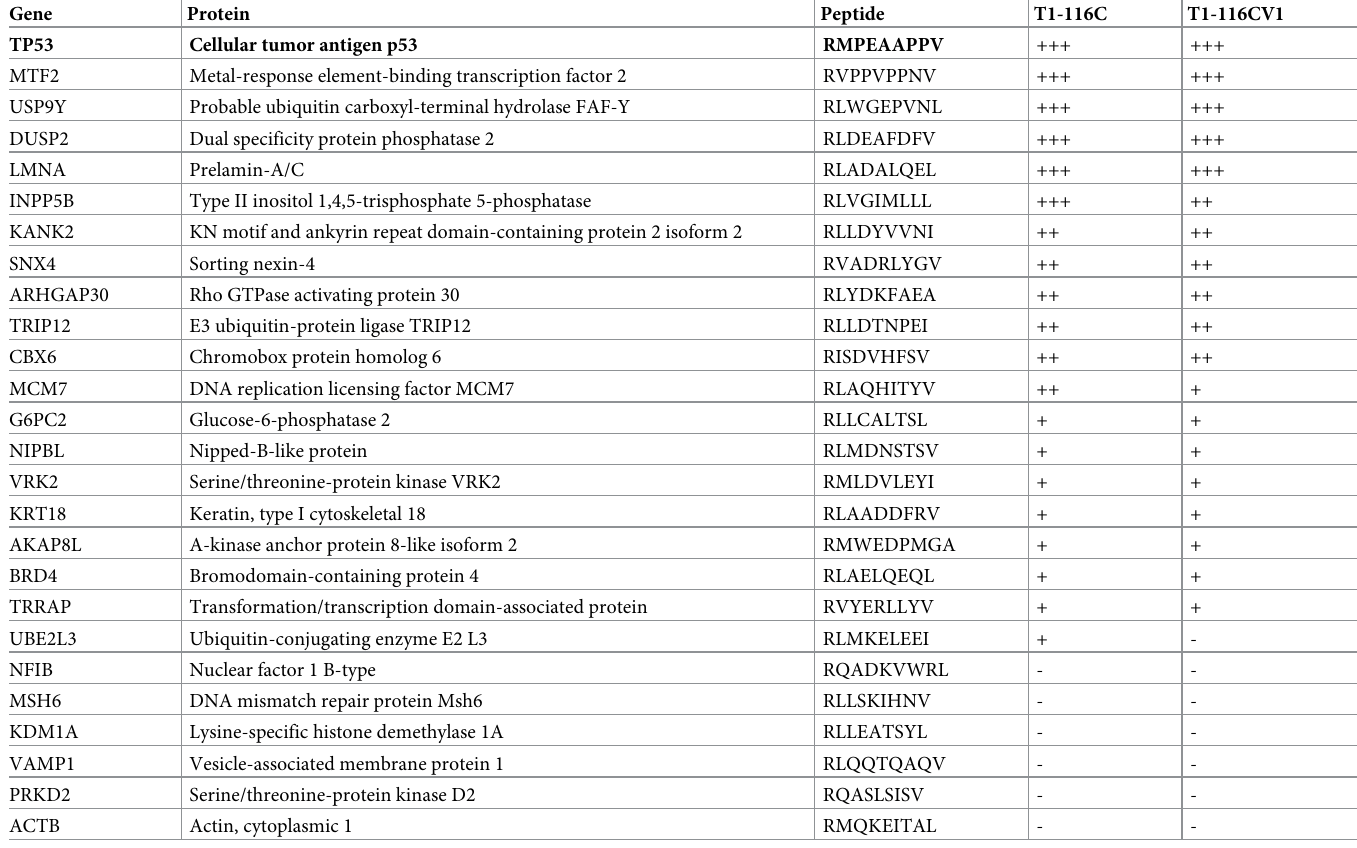
Table 1. T1-116C binding of peptides retrieved from the IEDB by using the complex binding consensus.